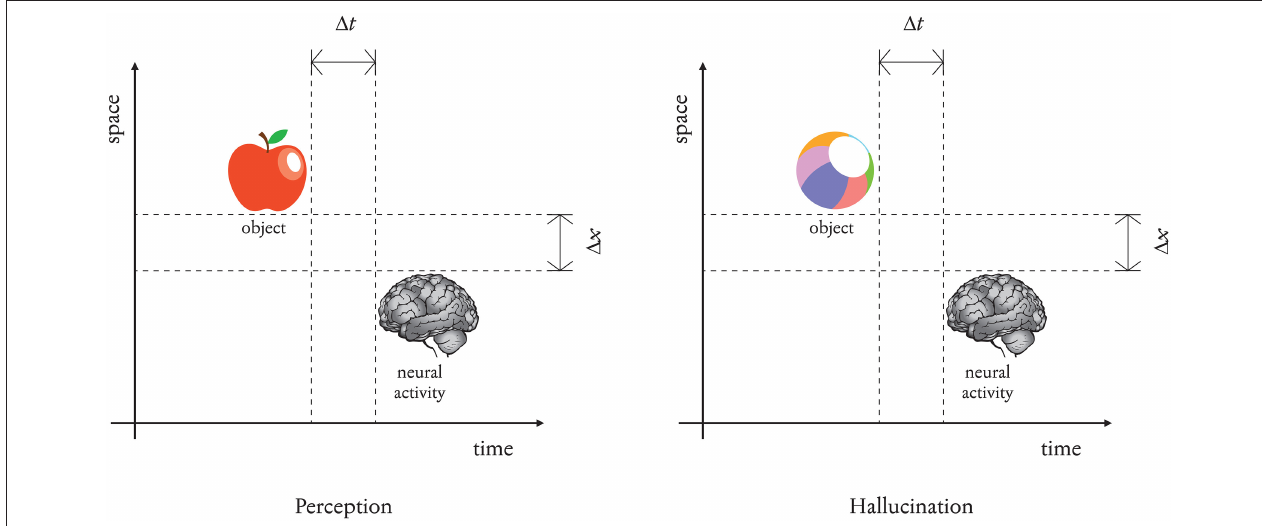
FIGURE 1 | Perception vs. hallucination. They are the same. Only the length of the time span is